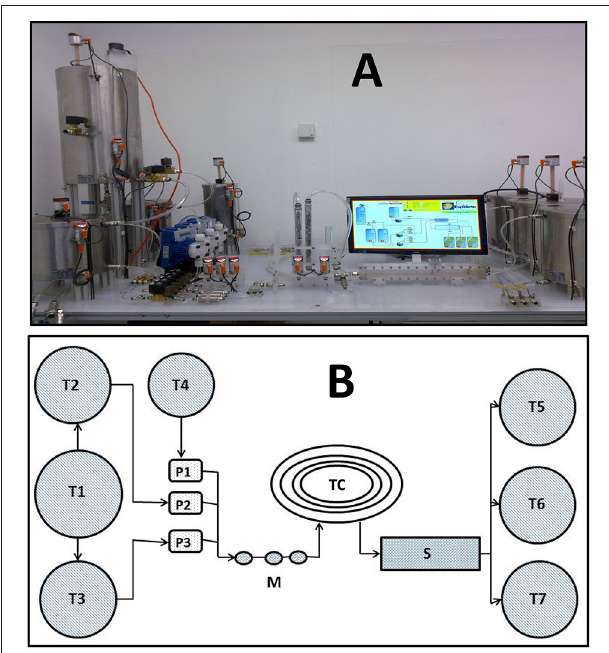
FIGURE 1 | Front view of the pilot plant configuration (A). Top view diagram (B) showing the main elements: Feeding tanks ( T1 , T2 , T3 , T4 ), Pumps ( P1 , P2 , P3 ), Static mixers ( M ), Tubular Coalescer ( TC ), Gravity Separator ( S ), Recollecting tanks ( T5 , T6 , T7 ).